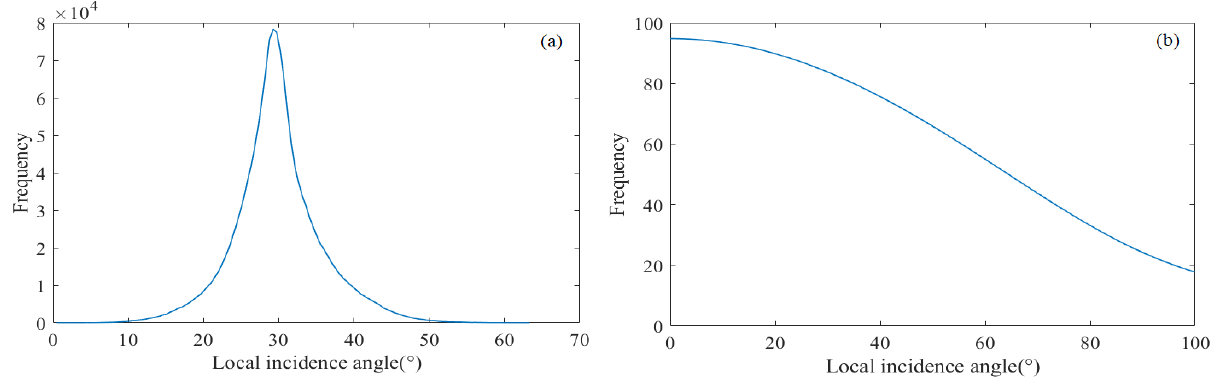
Figure 17. Analysis of local incident angle: ( a ) histogram of local incident angle frequency distribution; ( b ) relationship between local incident angle and snow depth.